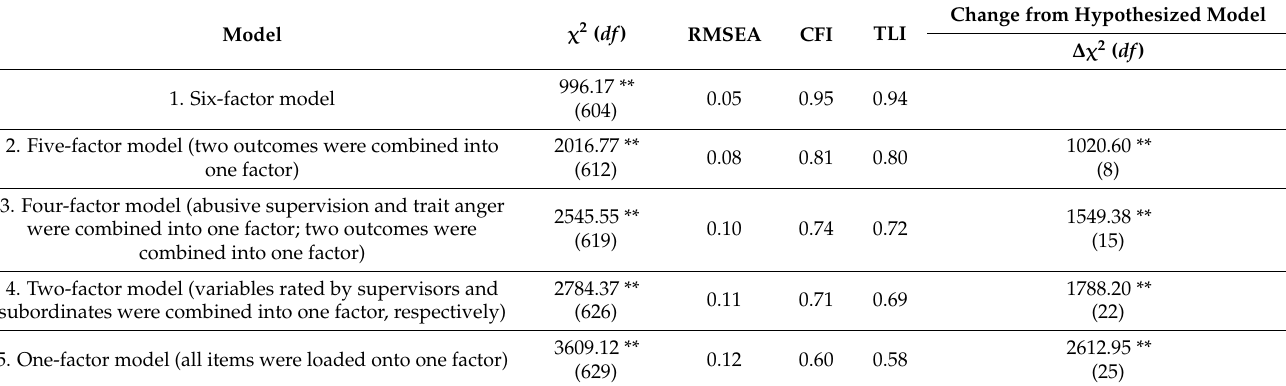
Table 1. Results of Confirmatory Factor Analysis for the Variable